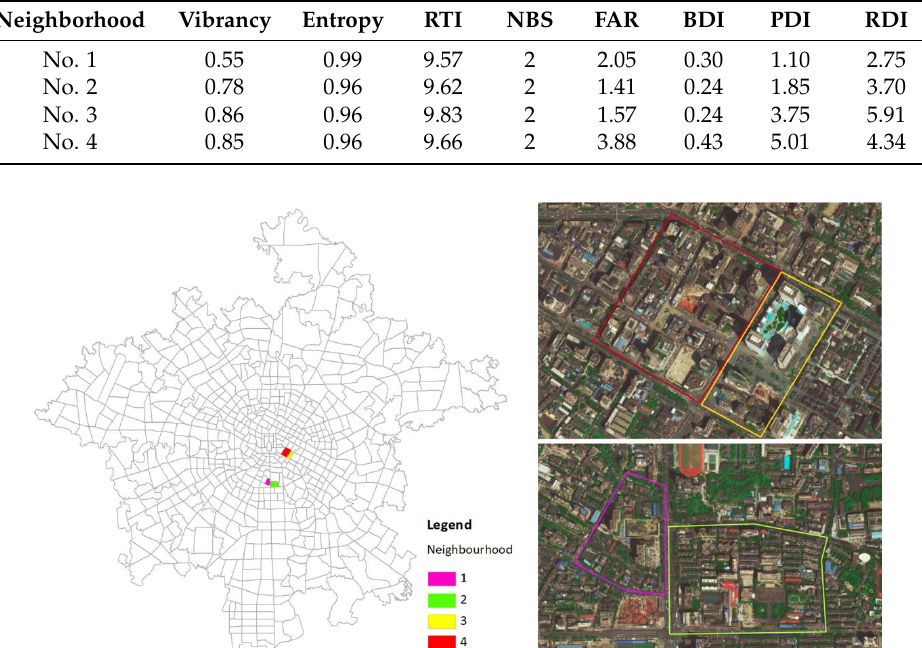
Table 5. Inner urban form indicators of the four selected neighborhoods.